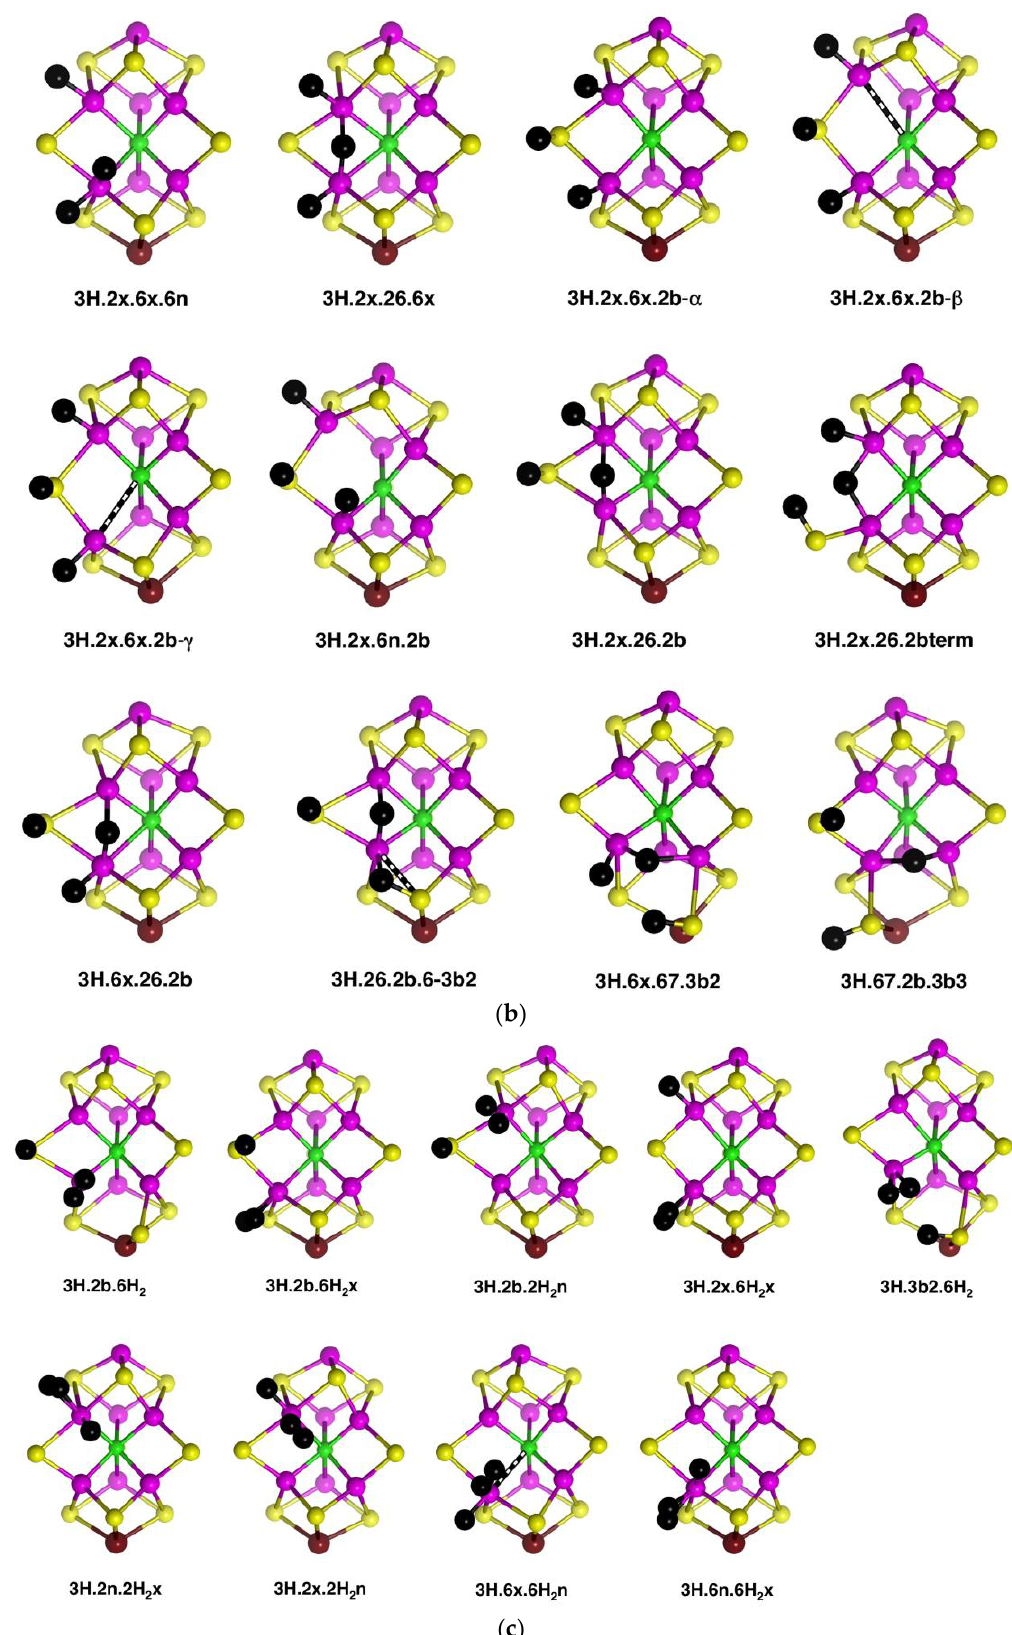
Figure 7. Optimised structures with three H atoms or H + H 2 bonded to FeMo-co. Fe–S distances less than 2.5 Å are drawn as bonds, Fe–S and Fe–C c distances in the range of 2.5 to 3 Å are marked with a black/white striped connector, and Fe–S non-bonds are greater than 3 Å . The α, β, γ suffixes distinguish C c –Fe distance isomers. ( a ) Structures combining the four conformations of S3BH with two